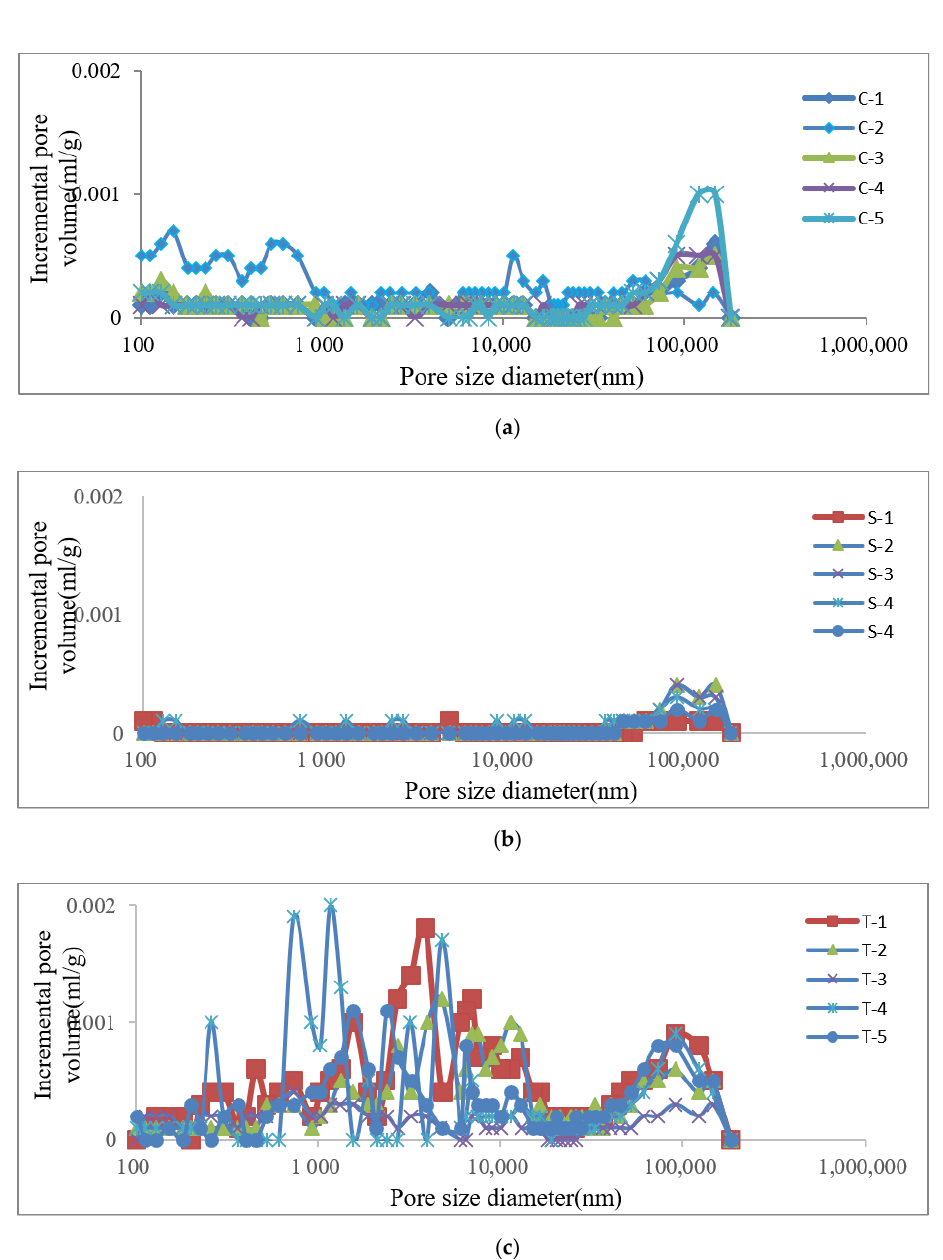
Figure 7. MIP incremental pore volume plots of macropores and mesopores of coal, shale, and tight sandstone samples. ( a ) Macro- and mesopore size distribution in high-rank coal samples. ( b ) Macro- and mesopore size distribution in shale samples. ( c ) Macro- and mesopore size distribution in tight sandstone samples.